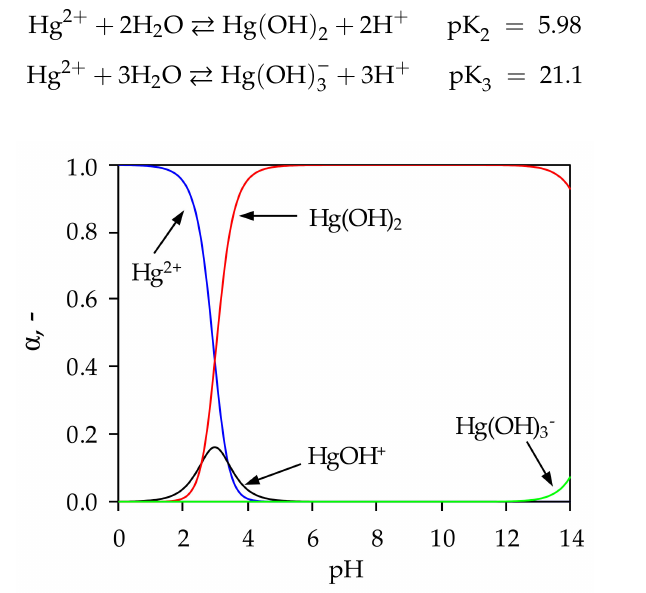
Figure 1. Distribution of Hg(II) species as a function of